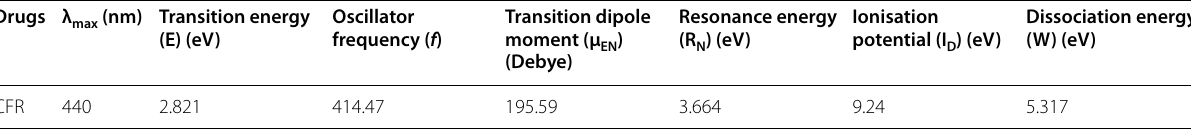
Table 3 Physicochemical parameters for the formation of charge transfer (CT) complex between CFR and N-(2,4-DN1NL) PTS Drugs λ max (nm) Transition energy (E) (eV)